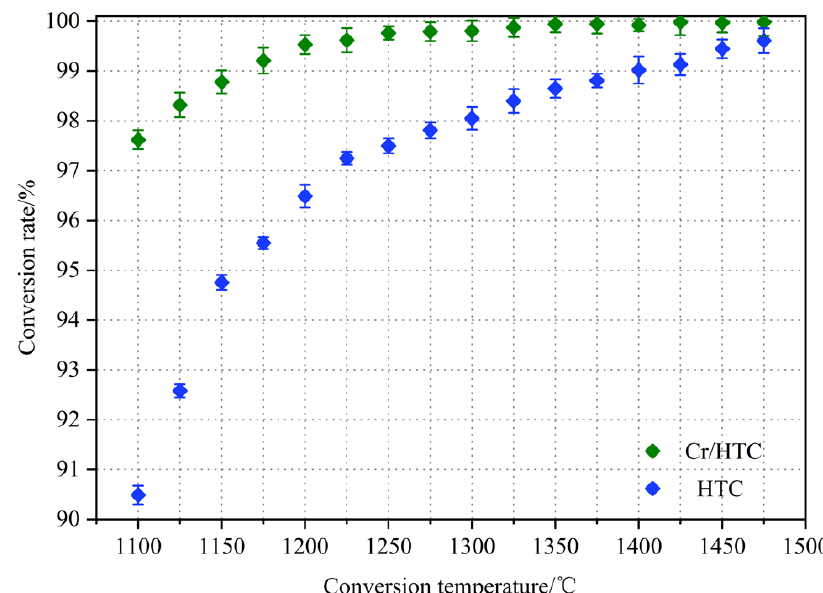
Figure 2. The conversion efficiency of n -hexane with changing pyrolysis temperature using the HTC and Cr/HTC methods.